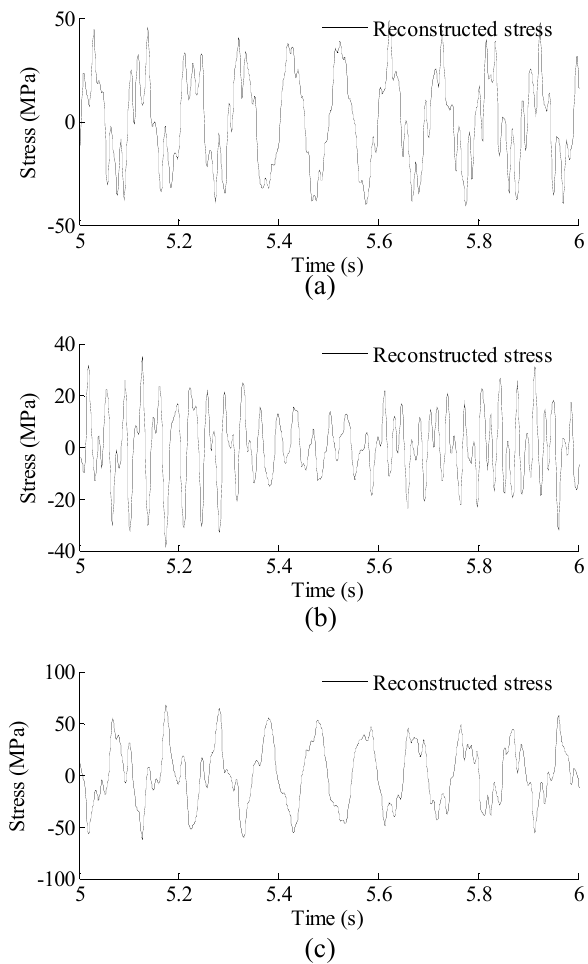
Figure 6. Reconstructed stress responses for three locations (Loc. 1–3) in Figure 2. Results are concentrated on 5–6 s for clear presentation. ( a ) Results for Loc. 1; ( b ) Results for Loc. 2; and ( c ) Results for Loc. 3.